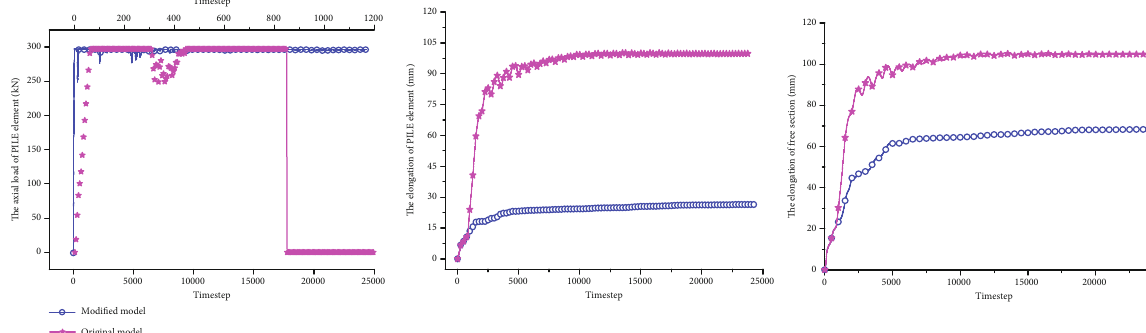
Figure 19: The relation curves of the axial load and elongation of the dangerous structural element ( CID = 529 ) and the variation law of the elongation of the whole free section by the timestep under the two models (rock bolt No.